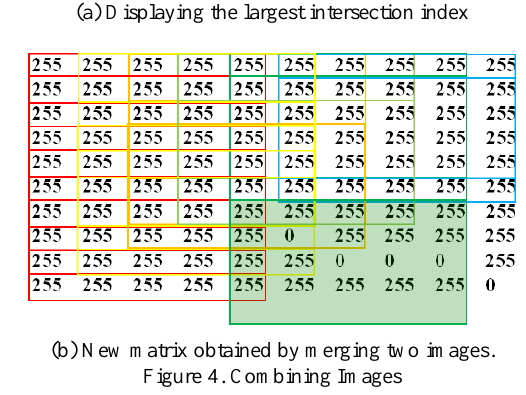
Algorithm1: A mapper function that computes the largest intersection between two images and performs two-image